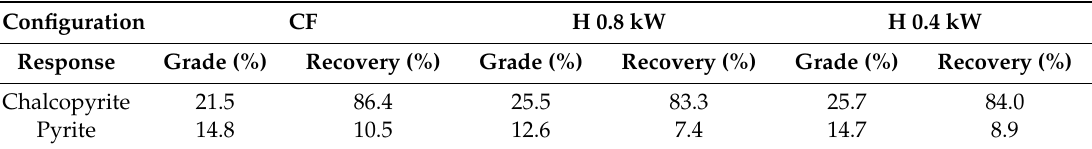
Table 4. Grades and recoveries of chalcopyrite and pyrite obtained in the presence and absence of the homogenizer operated at 0.4 kW and 0.8